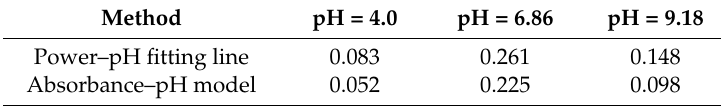
Table 5. Average absolute error of pH spectral model and fit line.